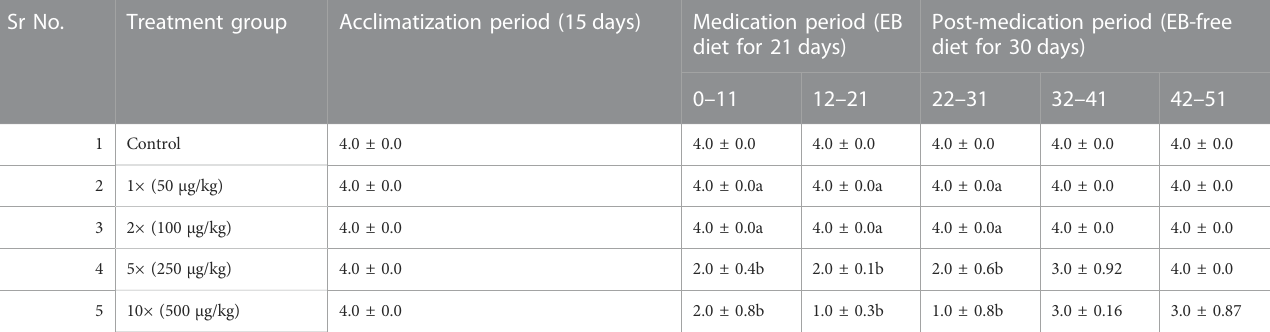
TABLE 2 Rating of feeding behavior of golden mahseer juveniles administered with graded doses of EB (1×-10×) and control fi sh fed with normal feed. Sr No.